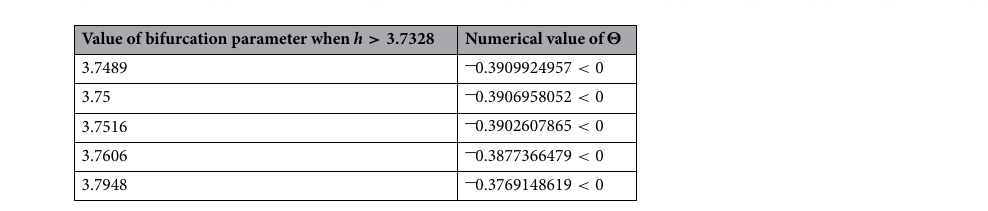
Table 1. Numerical values of (cid:31) for h > 3.7328 .